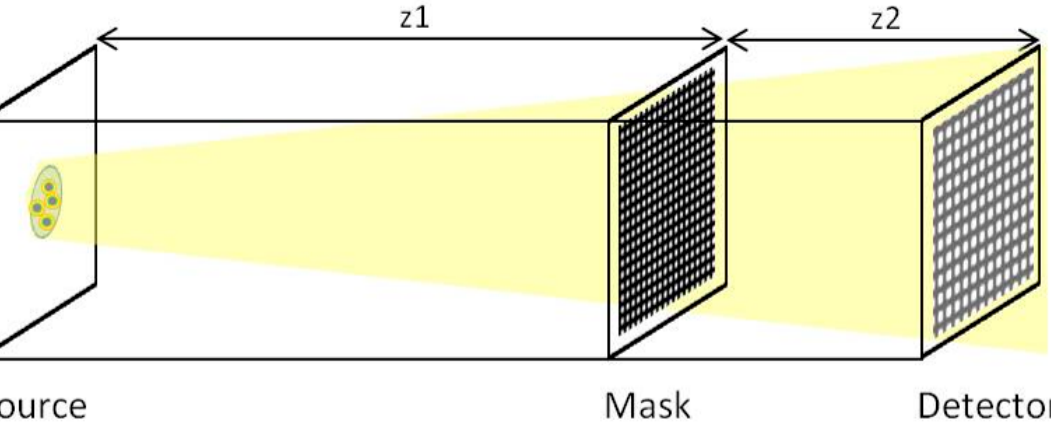
Figure 6. Schematic representation of the simulated set-up: the Hartmann mask is placed in the beam path between the source and the detector. z 1 is the source to mask distance and z 2 is the mask to detector